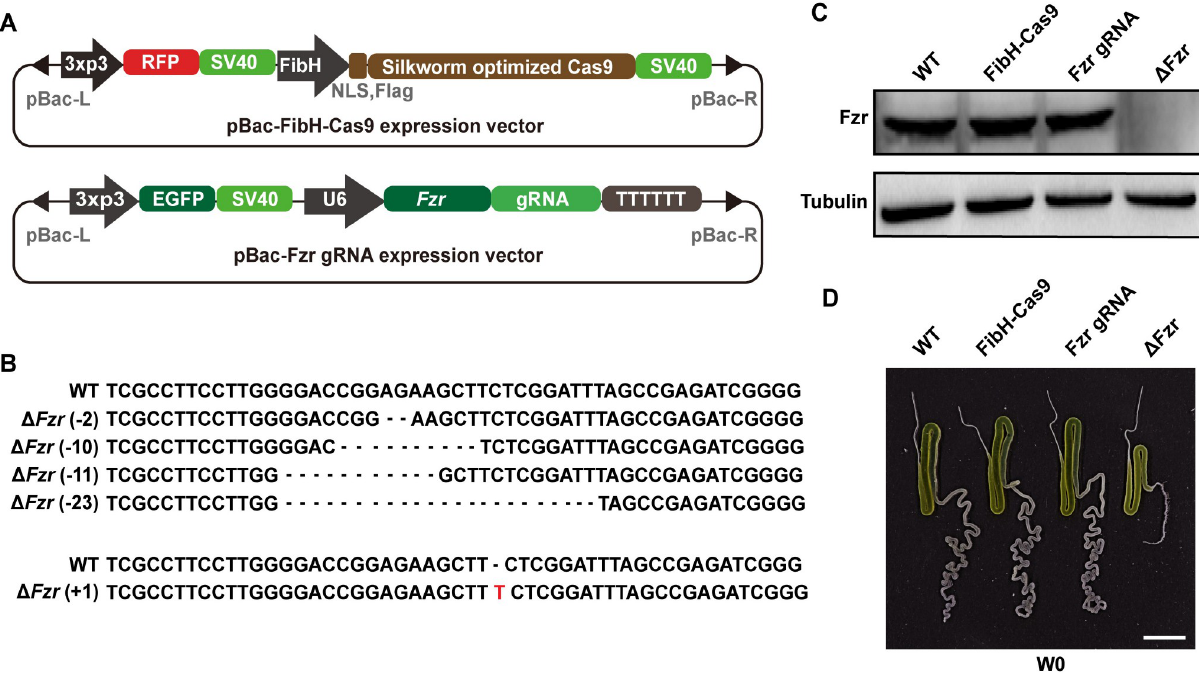
Fig 1. PSG-specific mutation of the Fzr gene decreases gland size in silkworm. ( A ) Schematic diagram of the recombinant plasmid used to mutate Fzr gene in silkworm PSG. ( B ) Genomic PCR products was sequenced to evaluate CRISPR/Cas9-mediated mutation efficiency. ( C ) Western blotting confirmed that Fzr was efficiently mutated in the PSG. ( D ) Fzr mutation resulted in a decrease in the PSG size. Scale bar, 1 cm. WT, wild type. W0, just wandering.